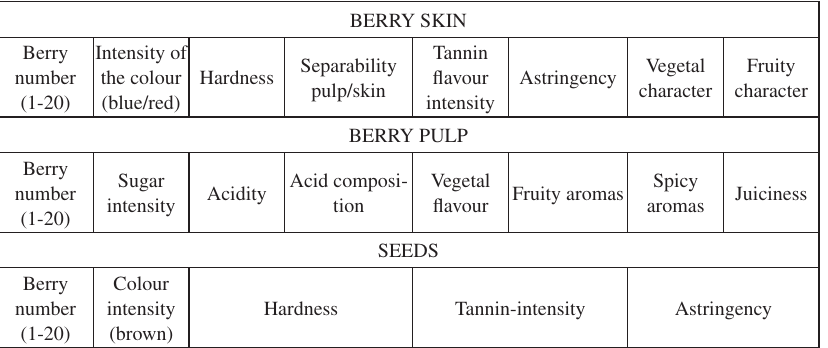
Table 2: Evaluation form for berry sensorial